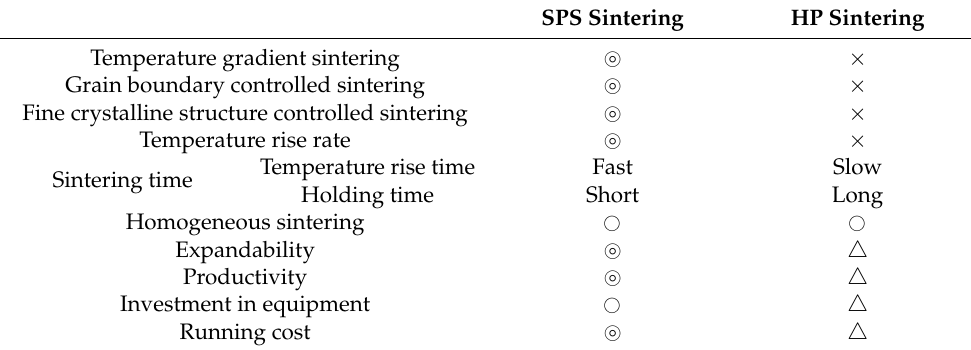
Table 2. Comparison of SPS and HP sintering characteristics.